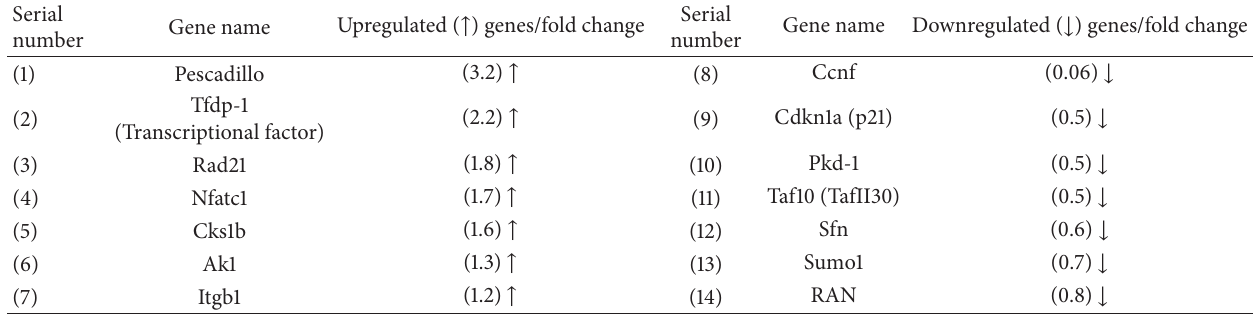
Table 1: List of differentially expressed genes in CD34+/ 𝛼 6-integrin+ stem cells from PKC 𝜀 TG mice. Overexpression of PKC 𝜀 in the epidermis results in increased expression of genes linked to cell transformation, invasion, and